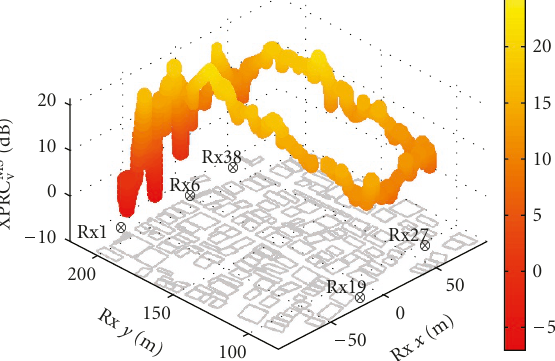
Figure 27: XPRC BS